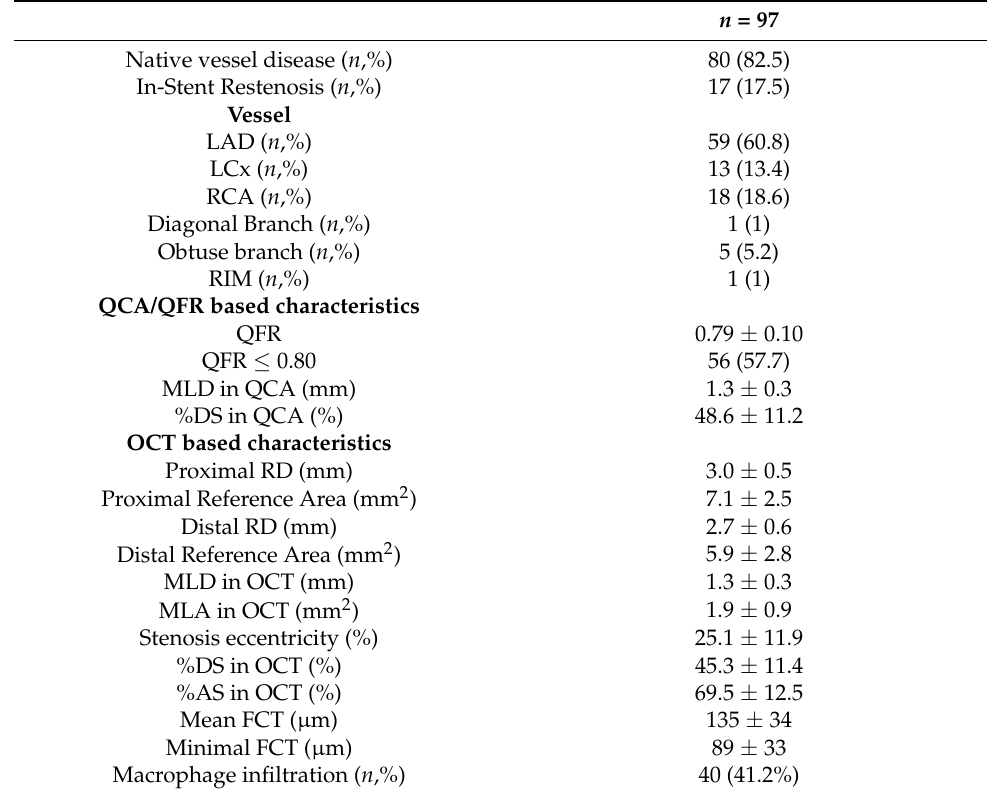
Table 2. Lesion characteristics.